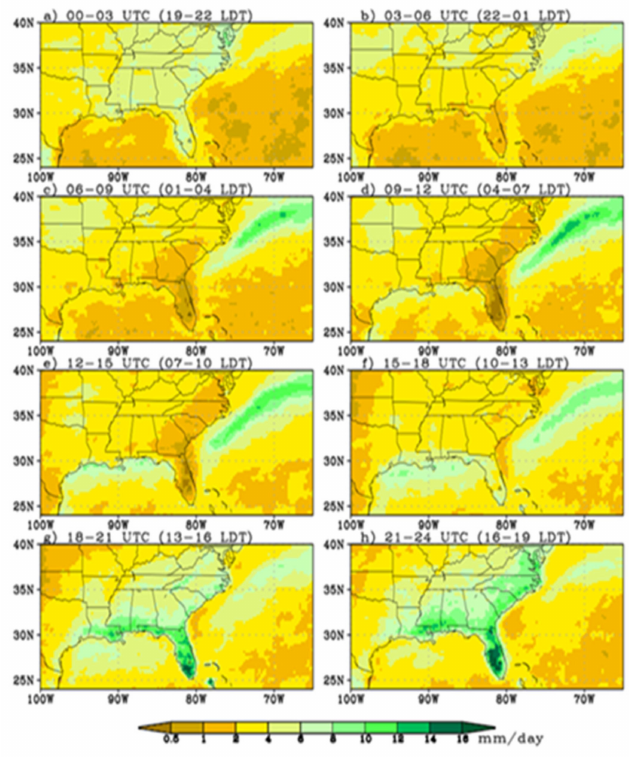
Figure 10. Same as Figure 7, but for